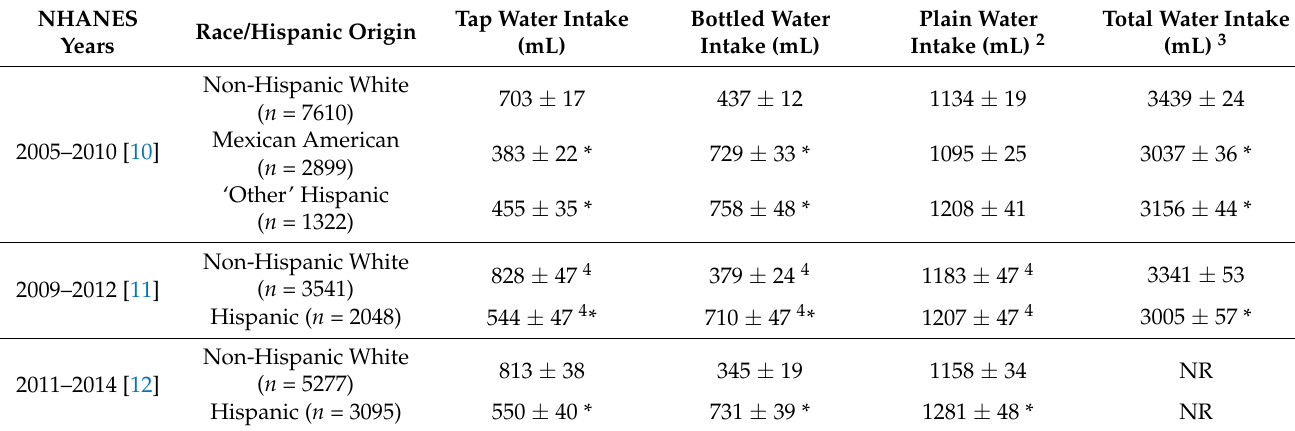
Abbreviations: NHANES, National Health and Nutrition Examination Survey; NR, not reported. 1 Data are presented as mean ± standard error; 2 Plain water intake refers to the total amount of water consumed via tap water and bottled water; 3 Total water intake refers to